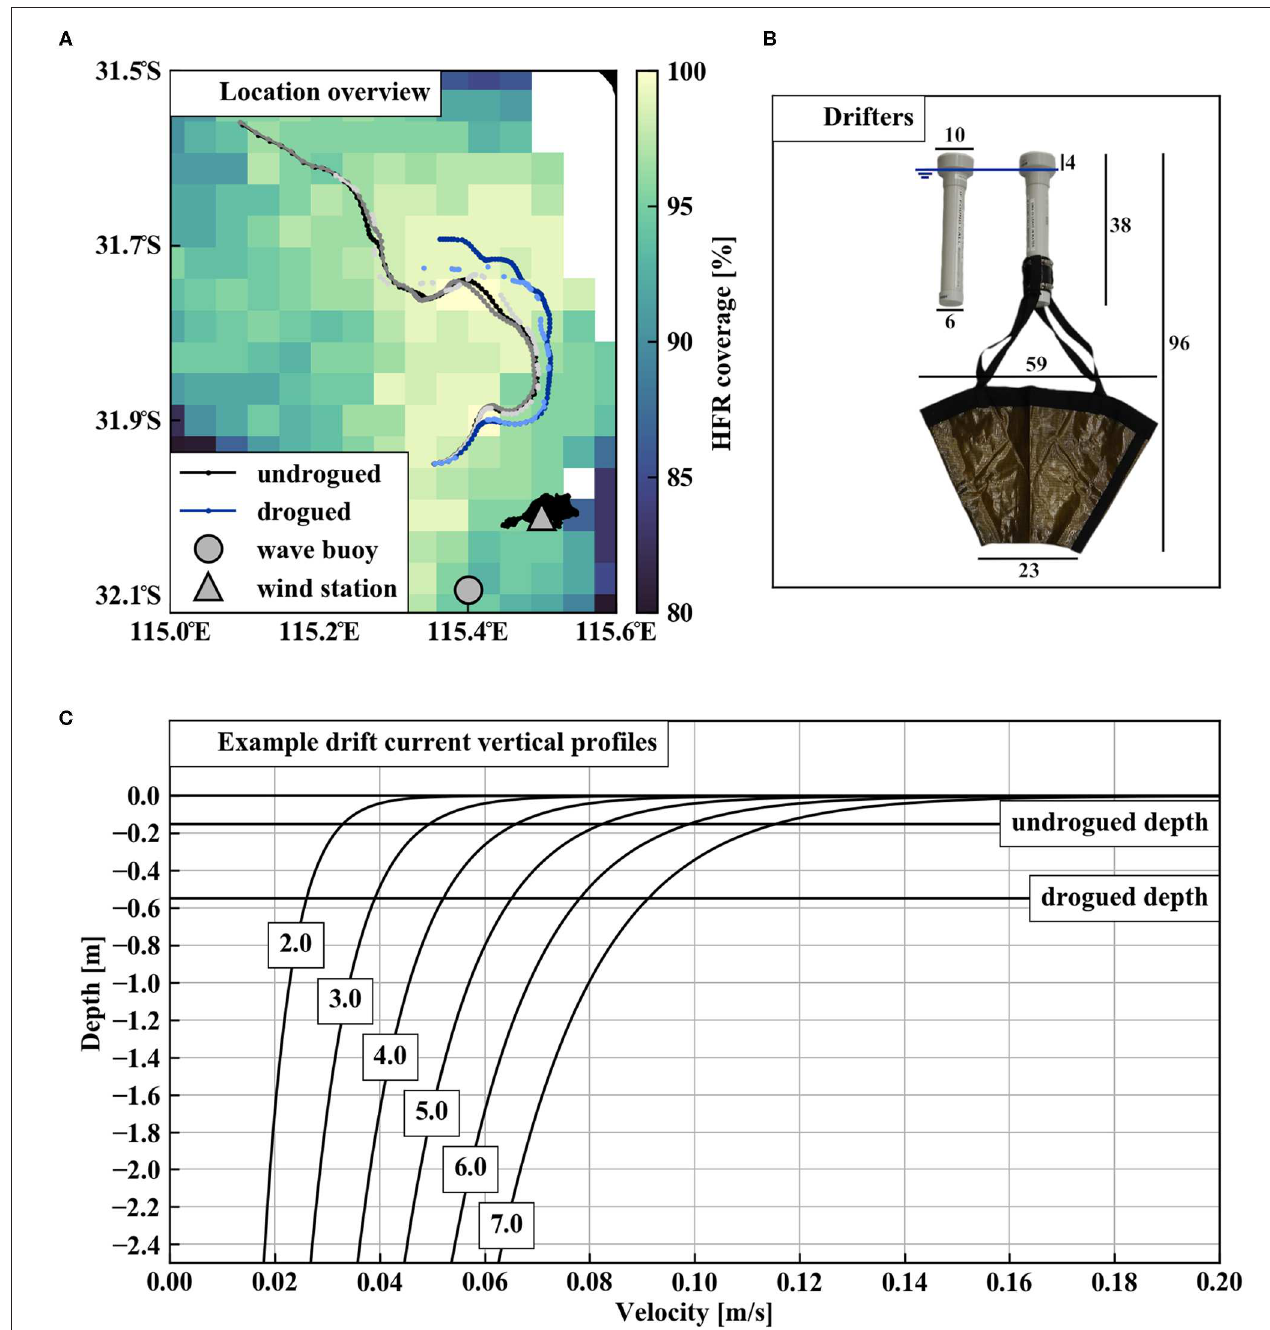
FIGURE 1 | (A) Overview showing: tracks of three undrogued and two drogued drifters for 5 days after release; HFR coverage of good quality data for 5 days after drifter release; locations of Bureau of Meteorology Rottnest Island wind station and Department of Transport wave buoy. (B) Photo of undrogued and drogued drifters with sizes indicated in centimeters (rounded up to whole centimeters). (C) Schematic showing: example vertical profiles of the logarithmic drift current for different wind speeds (numbers in text boxes for each profile indicate E u 10 speeds in m/s); representative depths of the undrogued and drogued drifters.